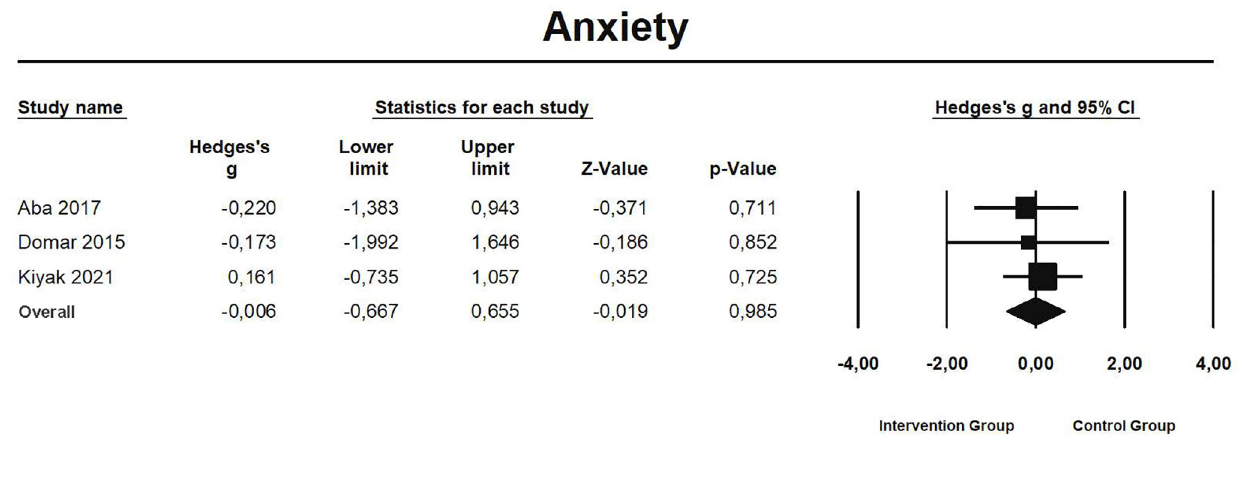
Fig 2. Results for anxiety. Hedges´ g, confidence interval (CI), Z-Value, p-Value and forest plot for anxiety (created with CMA Software [39]).